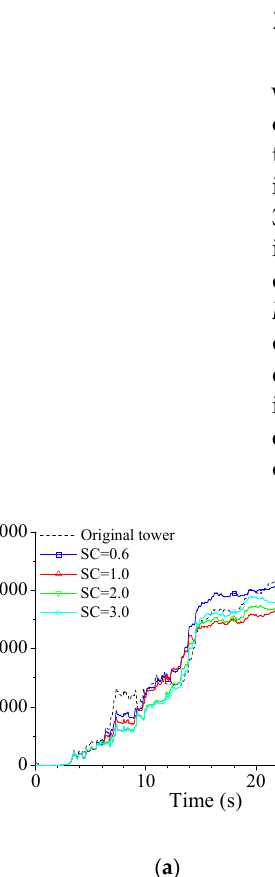
Figure 19. Energy responses of the tower with SMA dampers. ( a ) Taft; ( b ) El Centro; ( c ) Kobe; ( d ) Hachinohe.